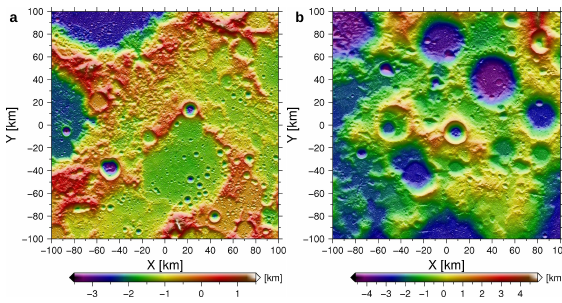
Table 1. Standard deviations of residual displacements of the original LOLA frame (left) and the new LOLA frame (right) with the north pole and south pole LOLA DTM. Values are given in meters in polar stereographic map coordinates x , y and height h .